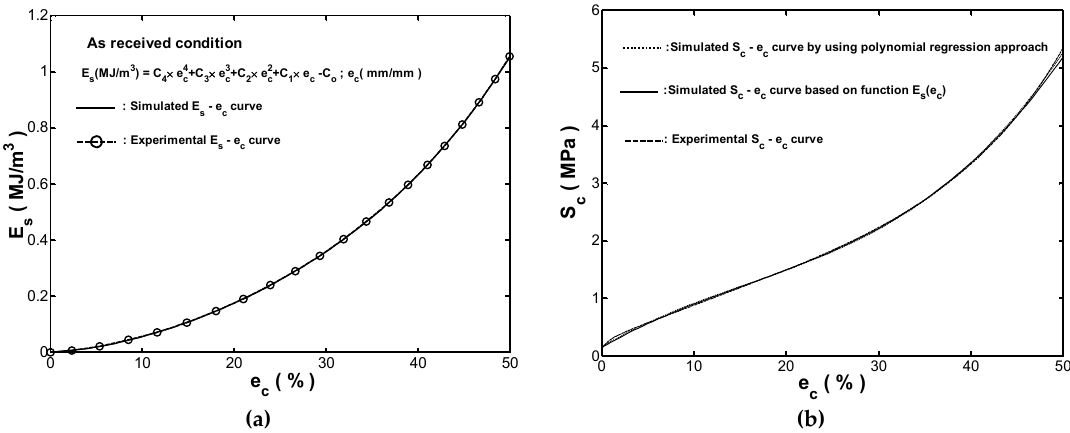
Figure 8. Comparison of experimental results and simulation results based on polynomial functions for ( a ) E s − e c curve, and ( b ) S c − e c curve.